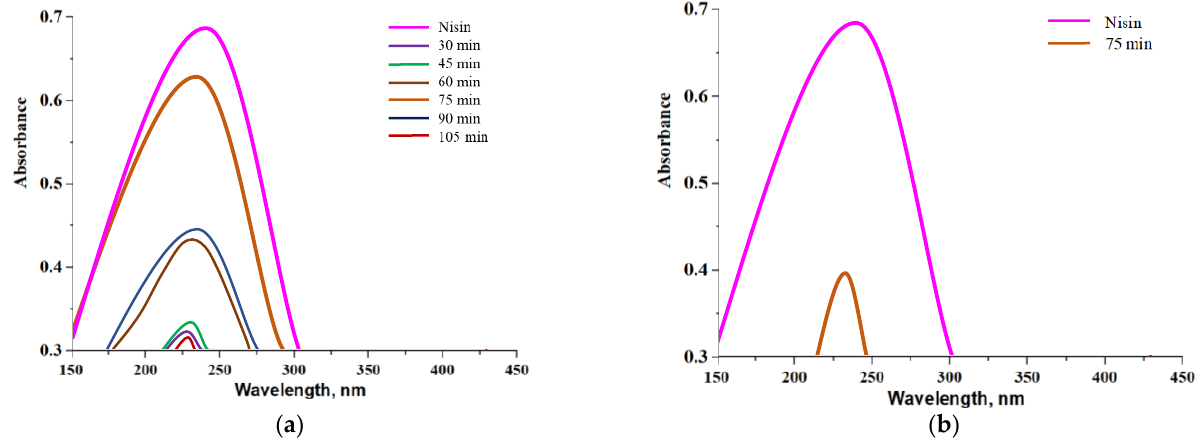
Figure 15. UV-Vis spectra showing a nisin release from chitosan/alginate-based capsules in an alkaline environment ( a ) and in acidic environment ( b ).